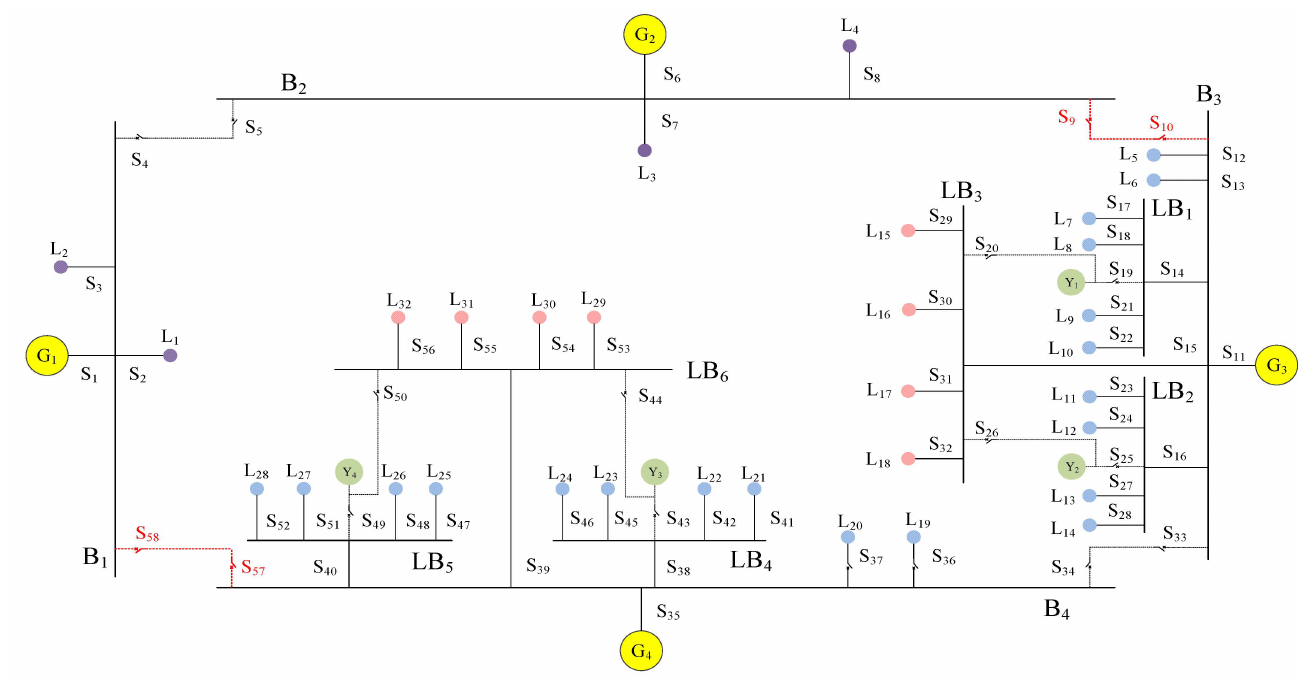
Figure 10. The revised system topology under fault scenario